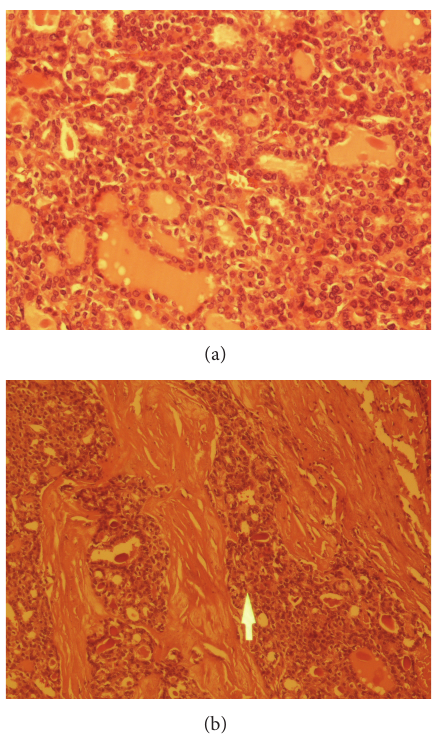
Figure 1: (a) A follicular structures in follicular carcinoma area composed of tumoral cells. (b) Oval polygonal shaped tumoral cells in medullary carcinoma area